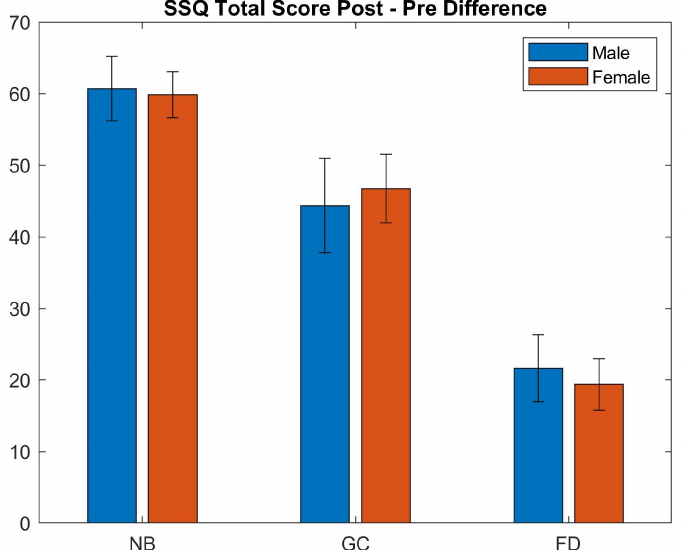
Figure 18. Comparison of the Post–Pre difference of the SSQ scores for each condition with respect to gender groups (conditions: NB—No Blur; GC—Unity Blur; FD—Ours). The plot shows the changes in individual SSQ total scores between the Pre and Post experiment conditions for the two age groups.